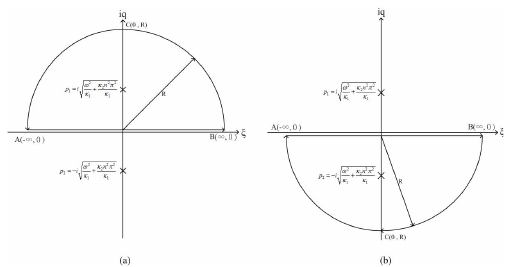
Fig. 9. Contour of